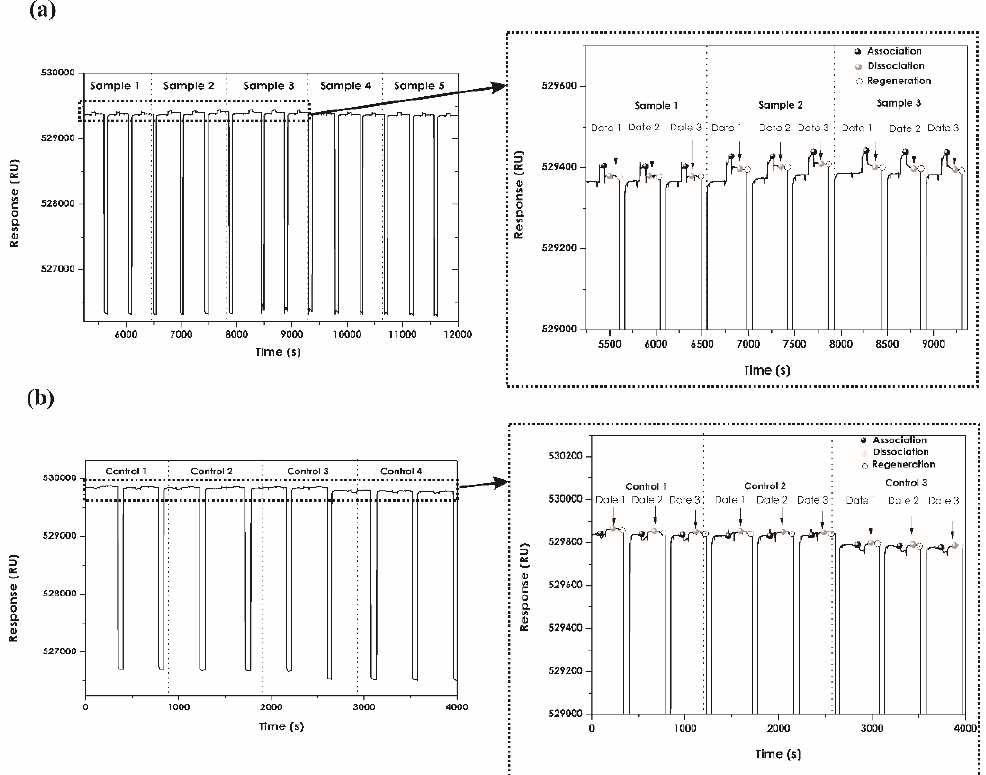
Figure 5. Association and dissociation sensorgrams for replicas of patient ( a ) and control ( b ) samples. Regeneration level with 0.0005% SDS. The RU obtained for patients having anti-TNF- α plasma levels was greater than that for controls (without anti-TNF- α ).